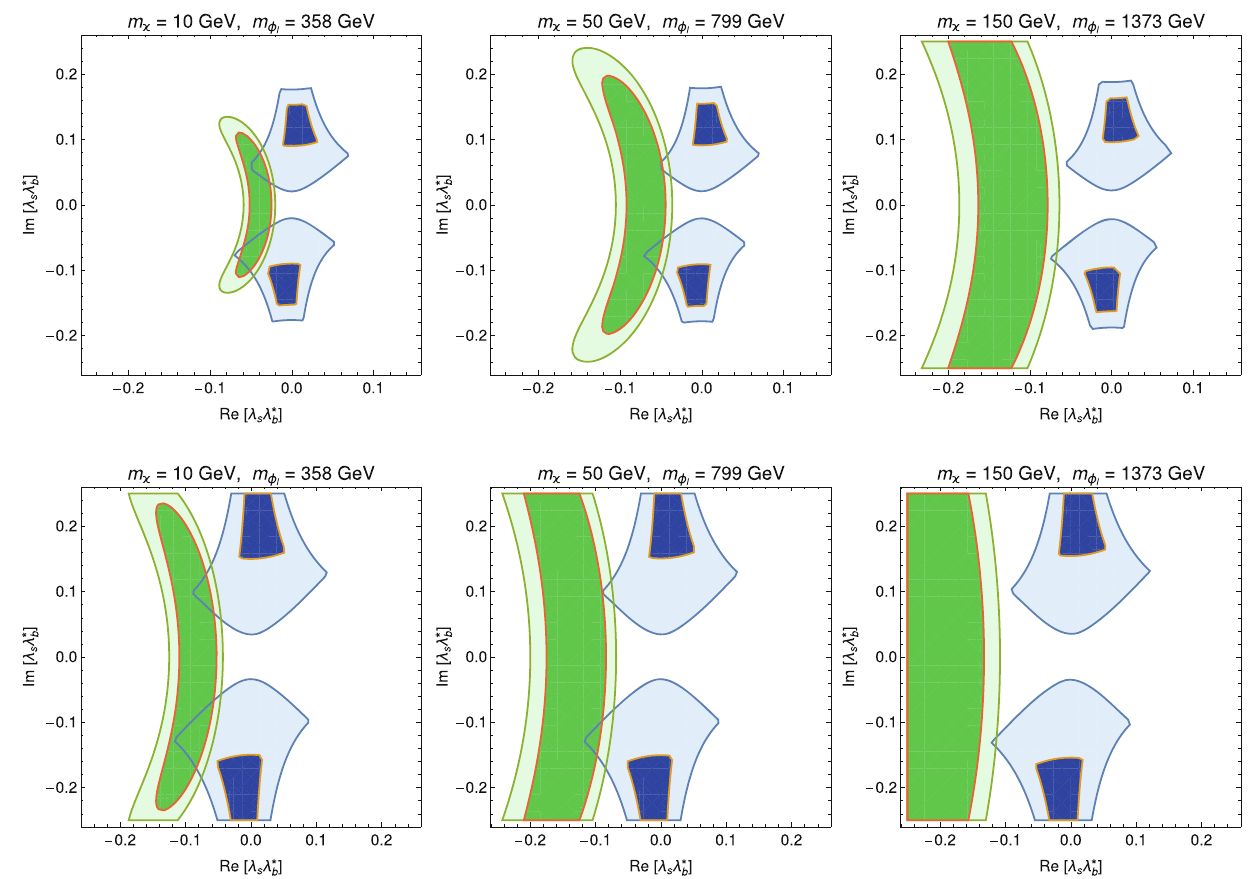
√ = 1 . 5TeV (top row), 2 . 5TeV (bottom 4 π and m φ We take λ μ = q ), Im (λ λ ∗ )) plane. Dark row). The specific values of m χ , m φ are given in the plot and m φ s b b l fixed to reproduce the measured DM relic